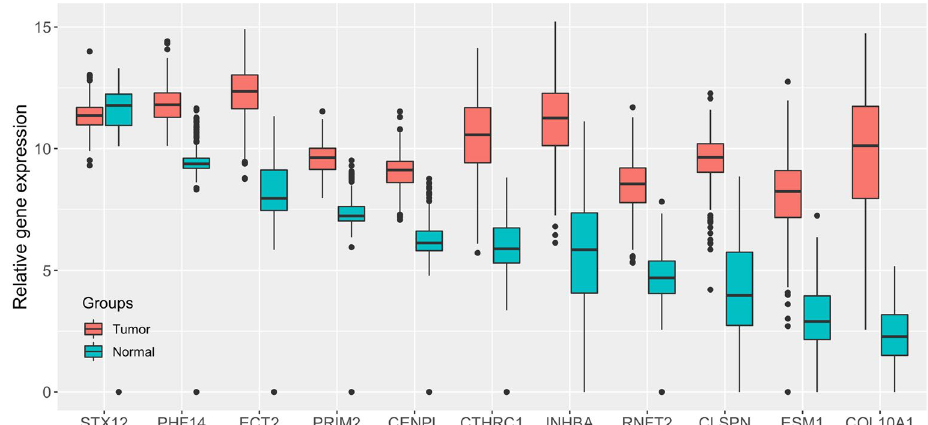
Figure 2. Relative expression levels of the 11 candidate genes in STAD tumor and normal samples. The data was obtained from the UCSC Xena website, and the boxplot displayed value ranges for each gene in two